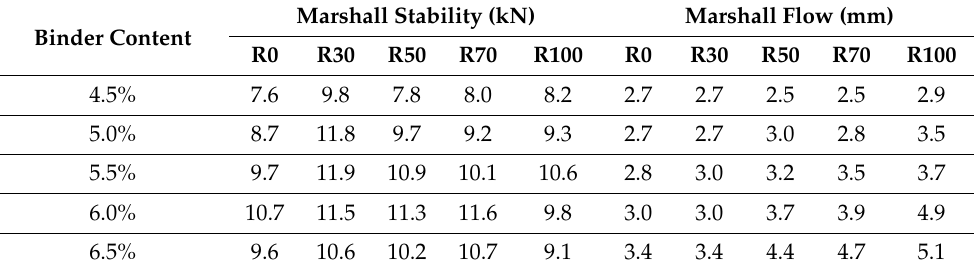
Table A1. Marshall stability and flow results in various binder contents.